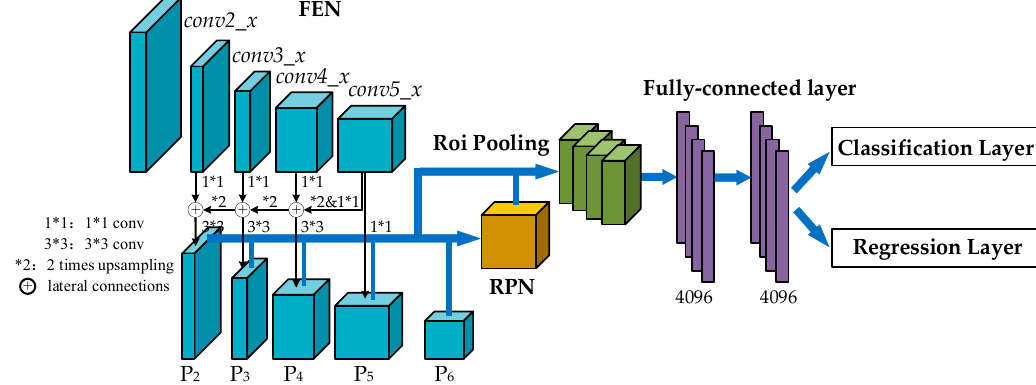
Figure 4. Architecture of the multiscale defect-detection network.